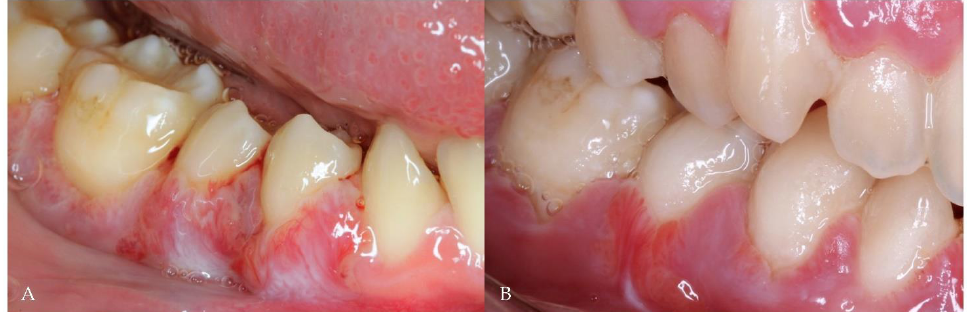
Figure 1. ( A ) Periodontal disease exacerbation; ( B ) Clinical outcome after one week of antibiotic therapy (without mechanical treatment).